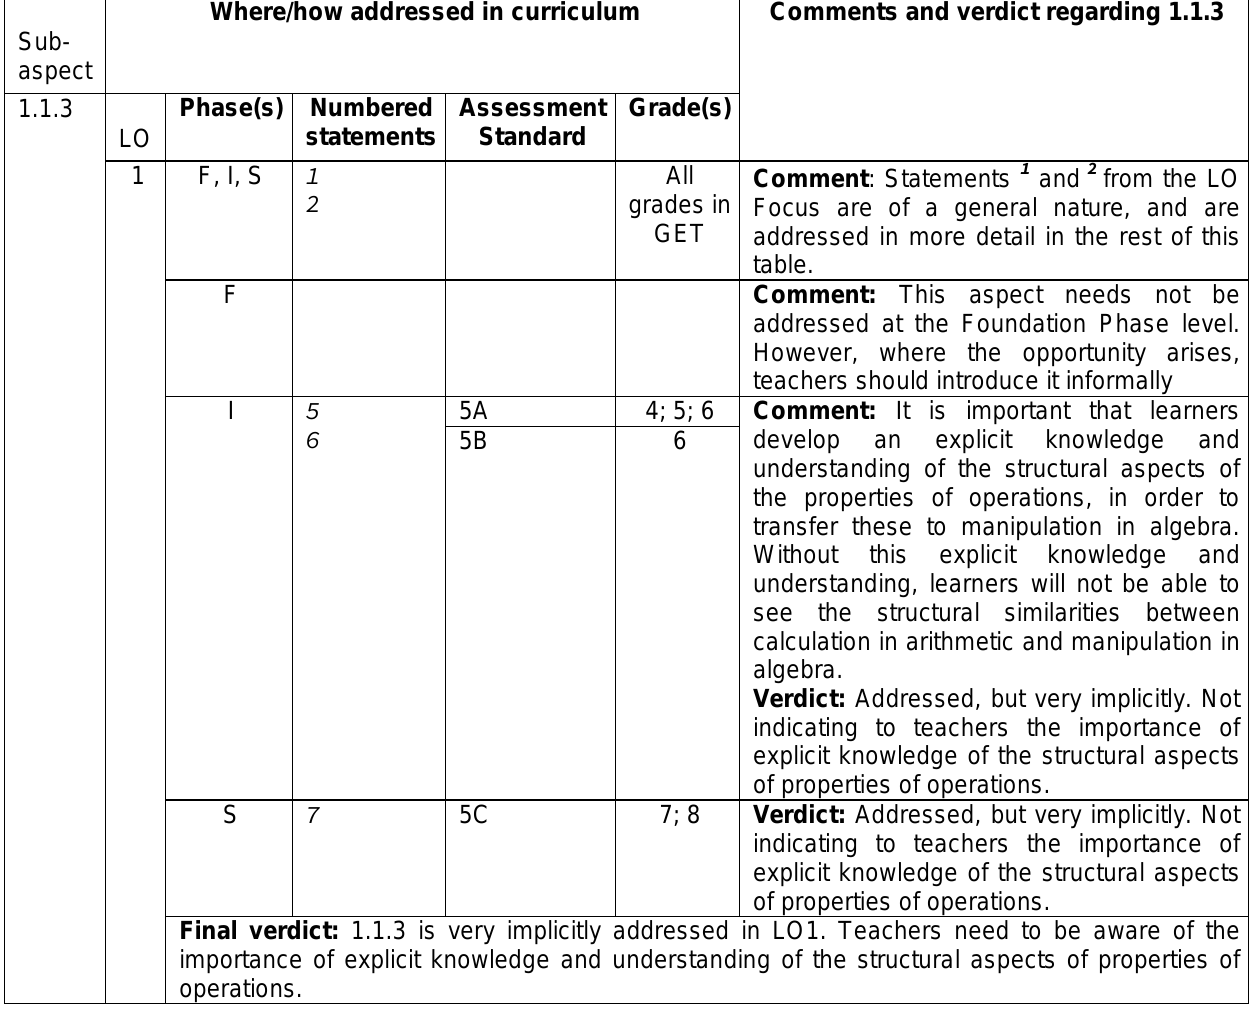
Aspect 1 (cont.): enable learners to experience and appreciate algebra as generalised arithmetic